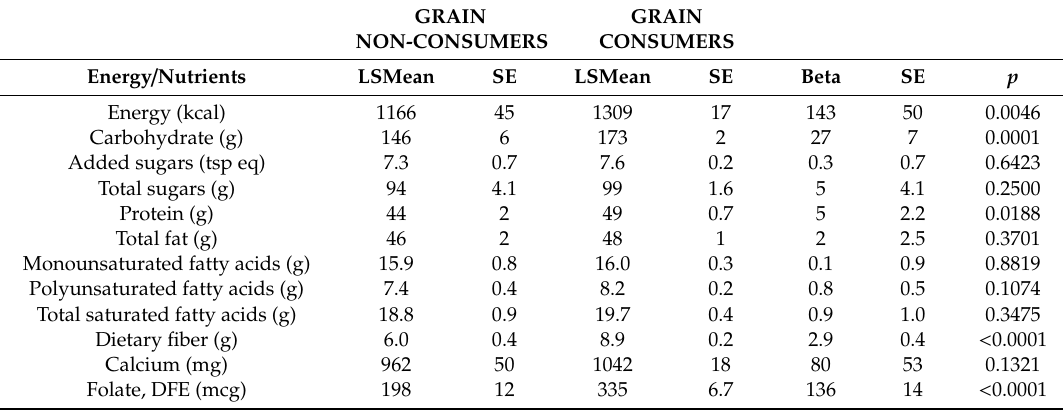
Table 2. Daily mean energy and nutrient intakes in 13- to 23-month-old grain consumers vs. grain